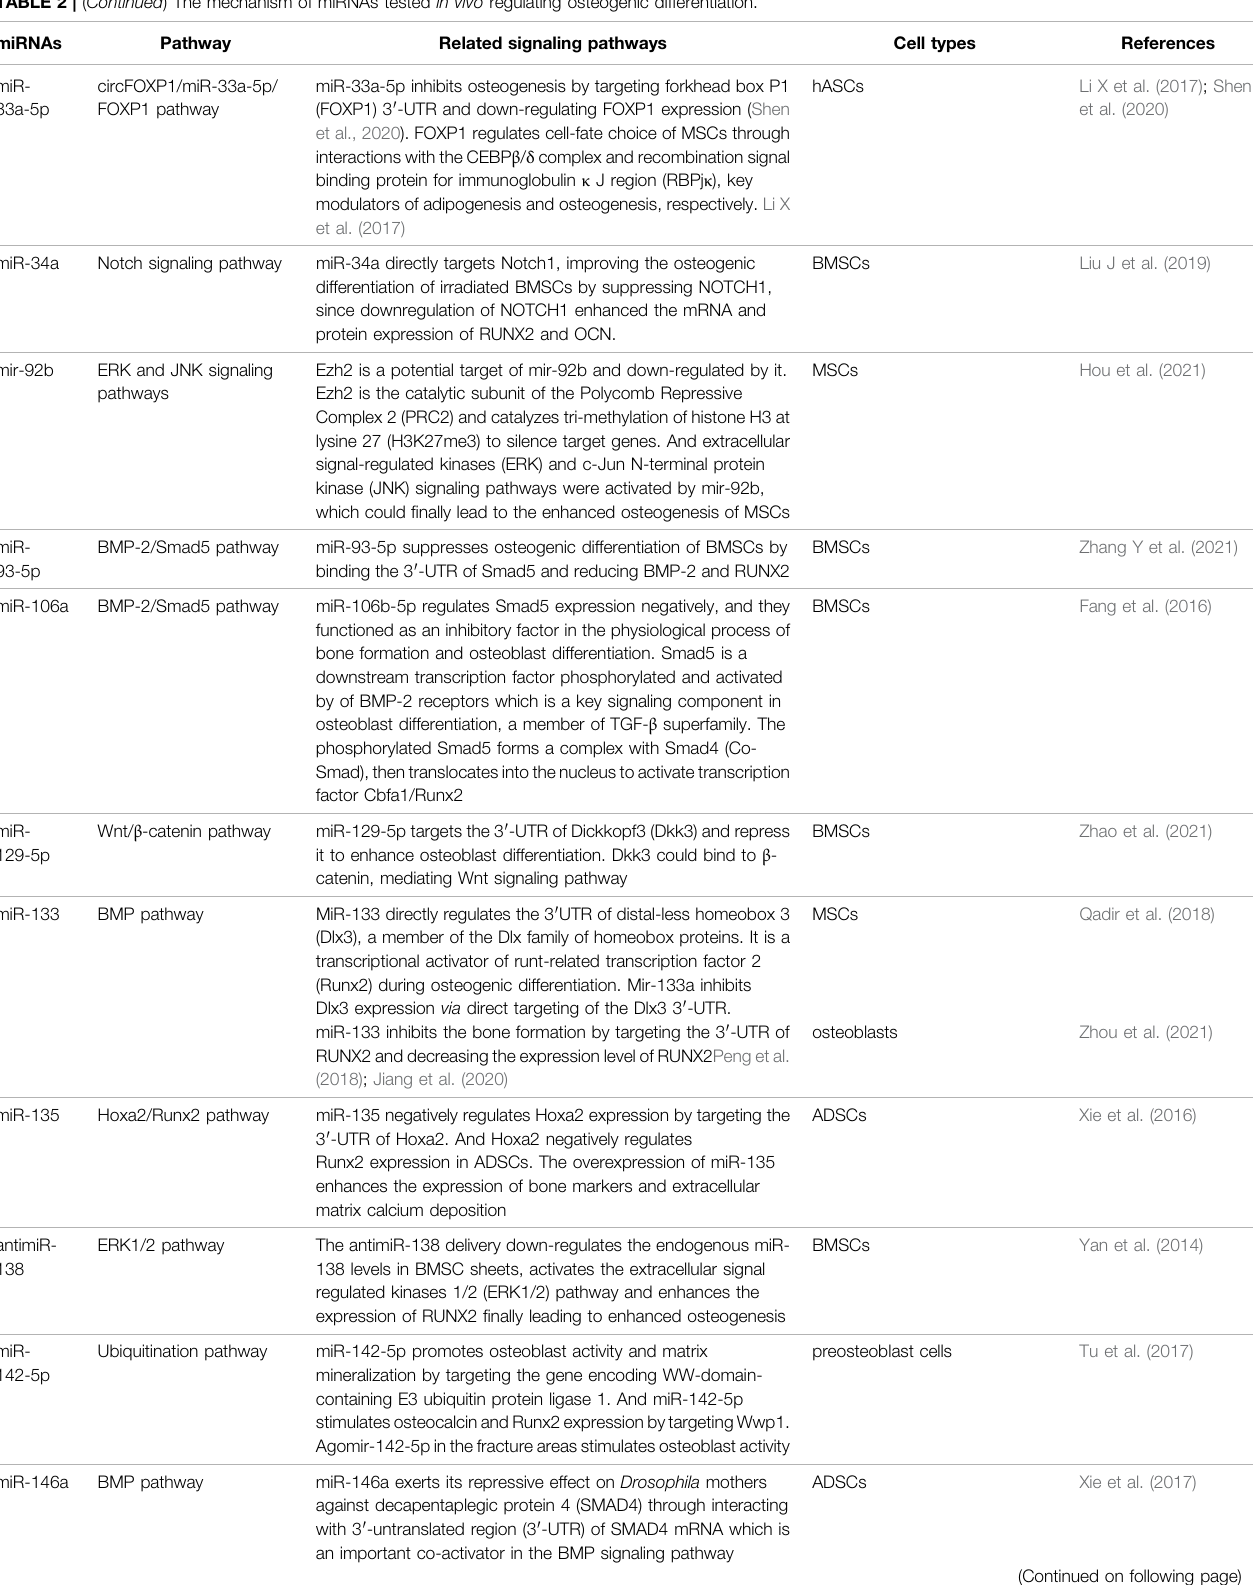
TABLE 2 | ( Continued ) The mechanism of miRNAs tested in vivo regulating osteogenic